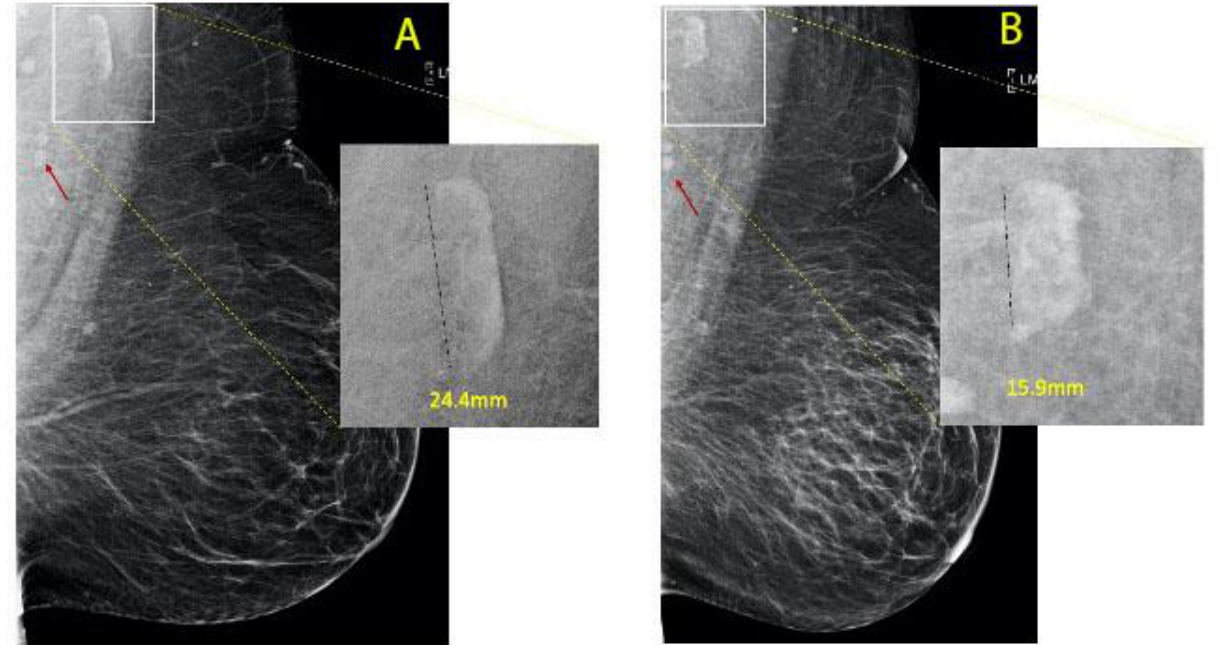
Figure 3. Left medio-lateral oblique mammogram before (( A ), 2016) and after (( B ), 2019) bariatric surgery. FIN (black dotted line) changed in size from 24.4 mm to 15.9 mm corresponding to a weight loss of 24.2 kgs. Normal lymph nodes for comparison (( A , B ), red arrows). There is an associated decrease in the size of the right breast due to marked weight loss and decreased breast adipose